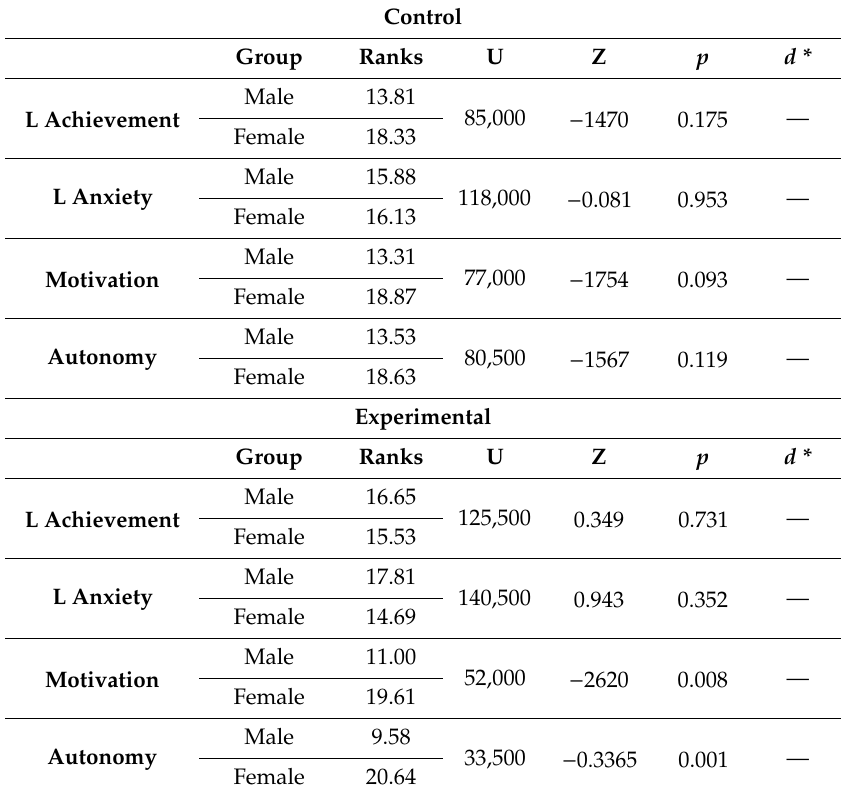
Table 3. Mann–Whitney U test for control and experimental groups di ff erences by